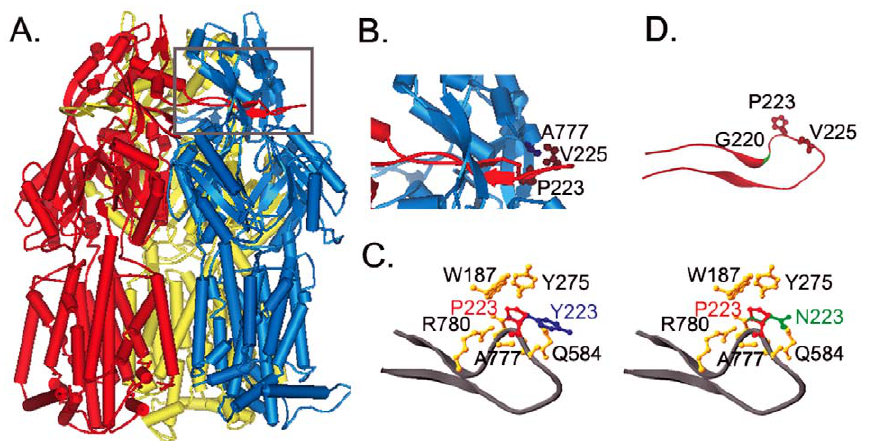
Figure 1. Crystal structure of AcrB. A. AcrB trimer with each subunit color coded (created from 2HRT.pdb). B. Zoom in view of the loop region (grey box in A). Residues P223 and V225 from the red subunit, and A777 from the blue subunit are highlighted using ball-and-stick models. C. Binding pocket of P223 (red). Residues that form the binding pocket of P223 were shown (orange). The conformations of Y223 (blue) and N223 (green) were also shown superimposed on top of P223. D. Ribbon diagram of the protruding loop at a different angle. Residues P223 and V225 are highlighted using ball-and-stick models. Position of G220 is highlighted in green.